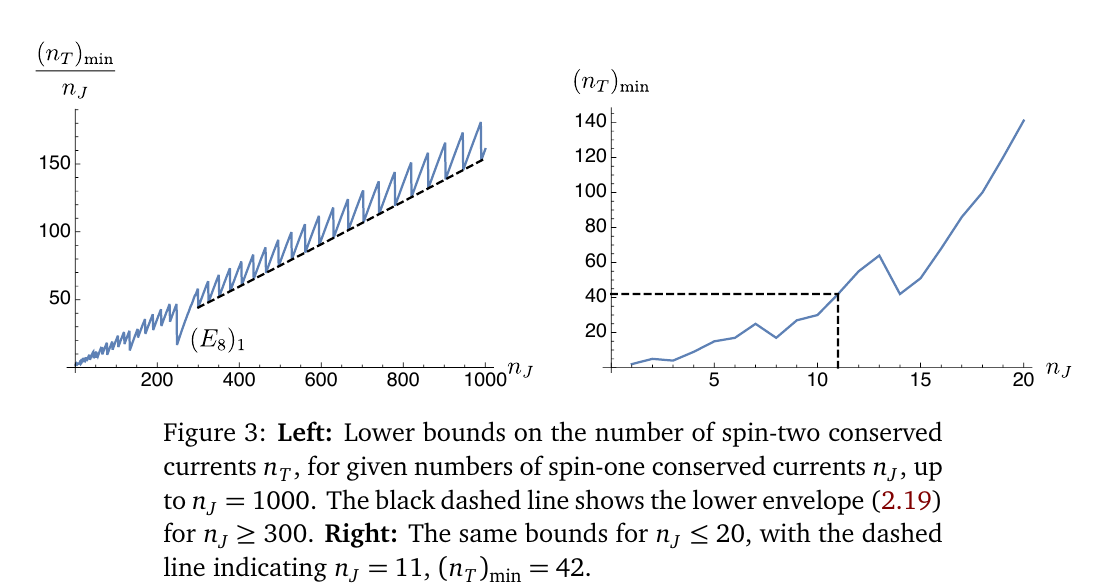
Figure 2: Left: Lower bounds on the central charge c for given num- bers of spin-one conserved currents n line shows the lower envelope (2.19) for n ≤ 20, with the dashed line indicating n bounds for n J = 3. c min